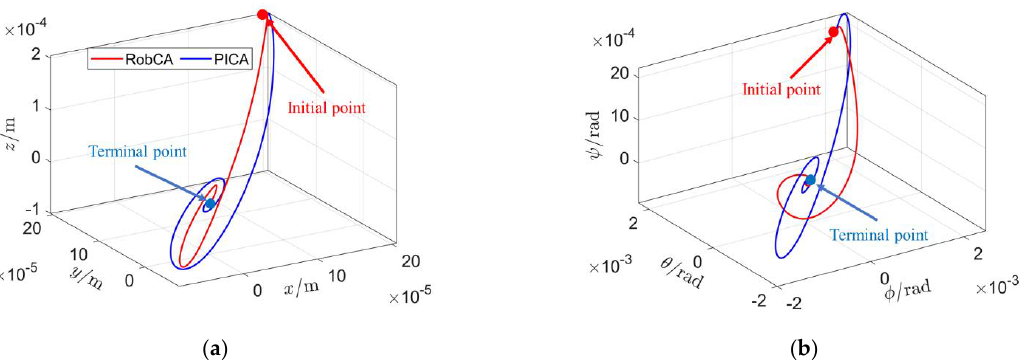
( f ) Figure 7. Time response comparisons of velocity and angular velocity of the test mass with the pro- posed RobCA method and the PICA method. ( a ) Velocity on x. ( b ) Velocity on y. ( c ) Velocity on z.